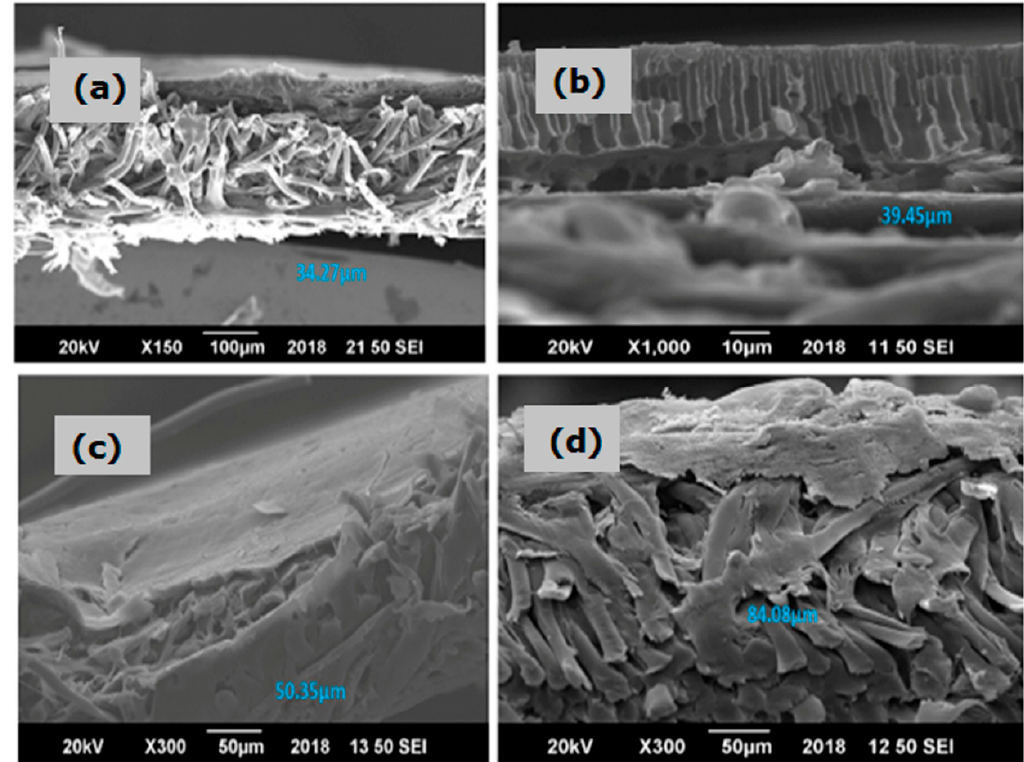
Figure 4. SEM image showing the morphology and width of the ( a ) pure polyethersulfone (PES) membrane, ( b ) cannabinoid embedded polyethersulfone (C-PES) membrane, ( c ) terpene embedded polyethersulfone (T-PES) membrane, and ( d ) cannabinoid and terpene embedded polyethersulfone (CT-PES) membrane.